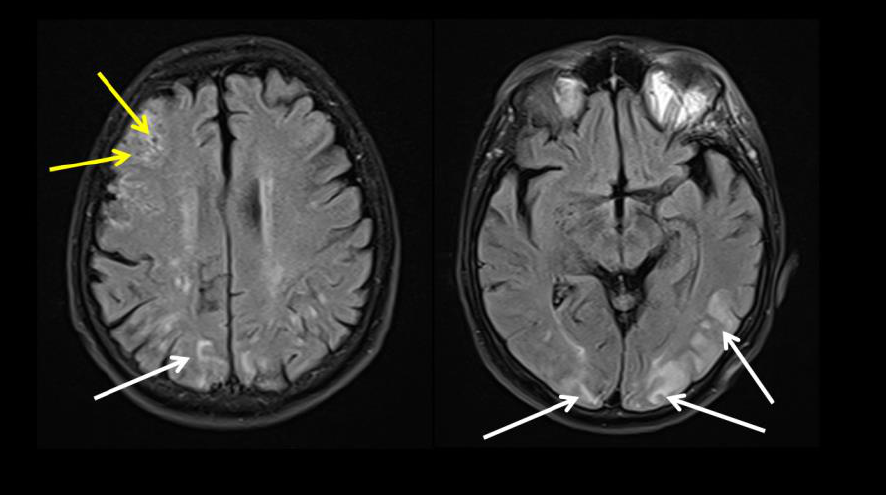
Figure 2. Brain MRI (FLAIR sequence) shows a combination of inflammatory lesions with involve- ment of U-fibers (white arrows) and cortical and subcortical vascular lesions with microbleeding (yellow arrows), typical for small vessel vasculitis.